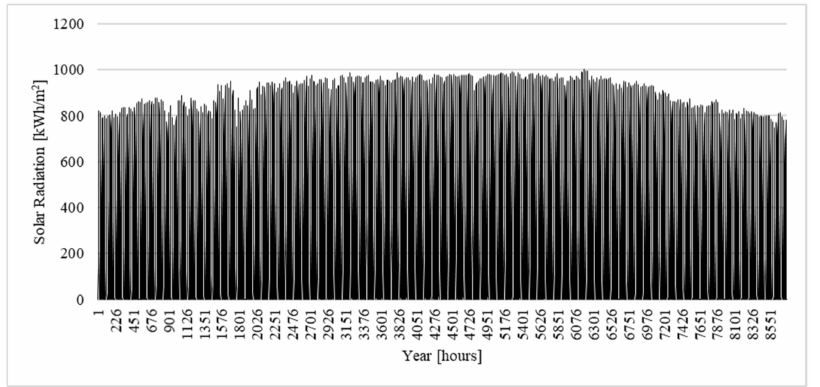
Figure A4. Hourly global solar radiation in the year 2019 at the model community based on data from [45].